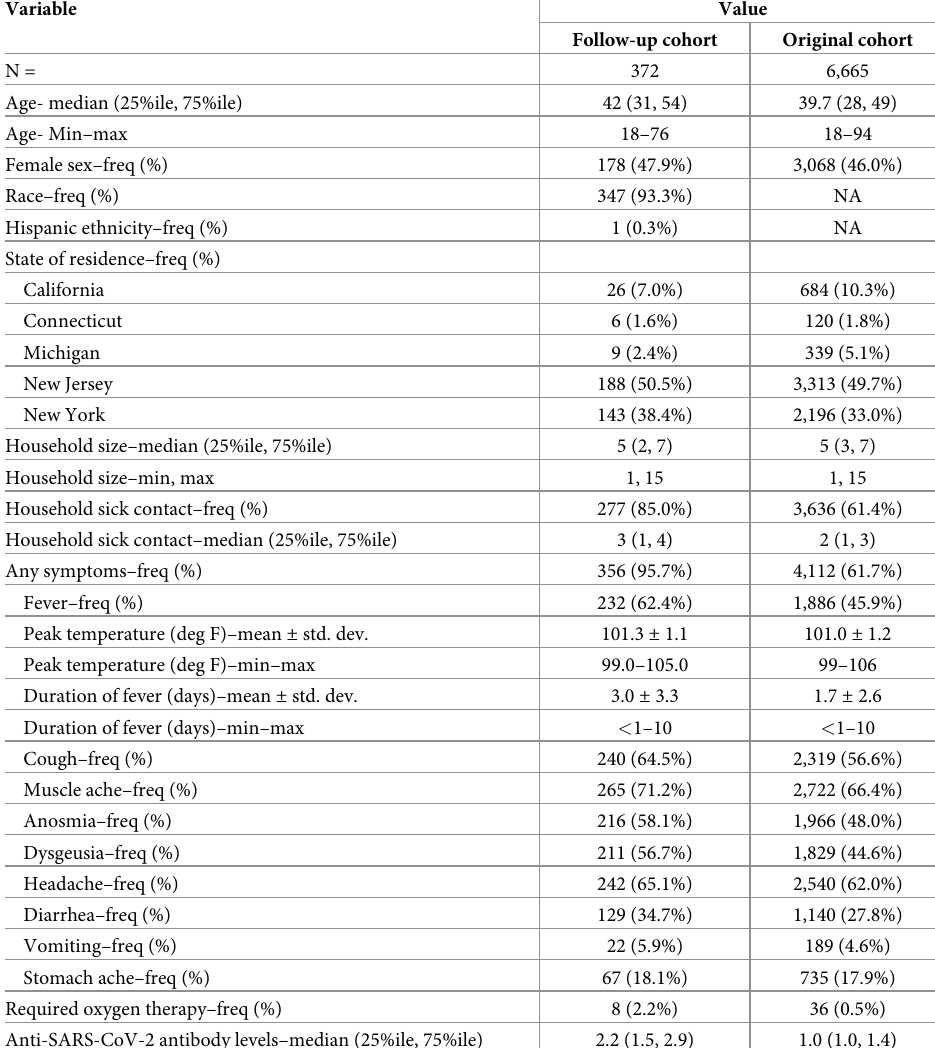
Table 1. Population